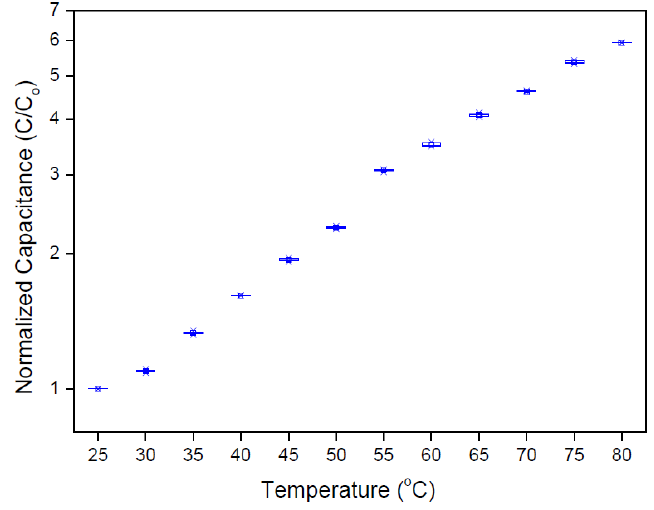
Figure 5. Capacitance-temperature relation for ITO/CuTsPc solution/ITO